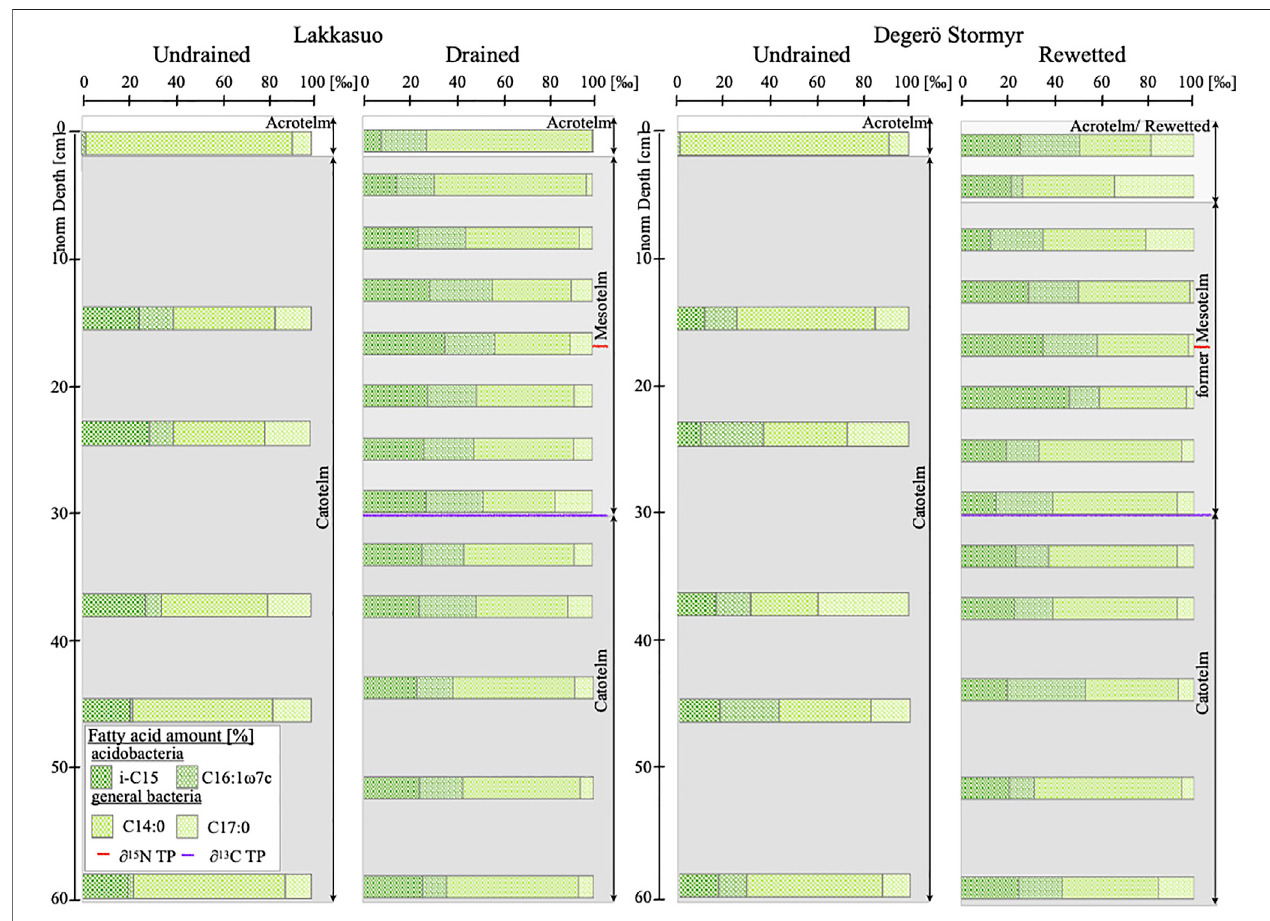
FIGURE 3 | Relative amount of bacterial-derived membrane fatty acids, separated for general and acidobacterial markers Lakkasuo (undrained, drained) and DegeröStormyr(undrained,rewetted)inthecoresof2013;Redreferencelinegivesthe δ 15 Nturningpoint(TP; Statisticalanalysis ),violetreferencelinegivesthe δ 13 CTP Statistical analysis